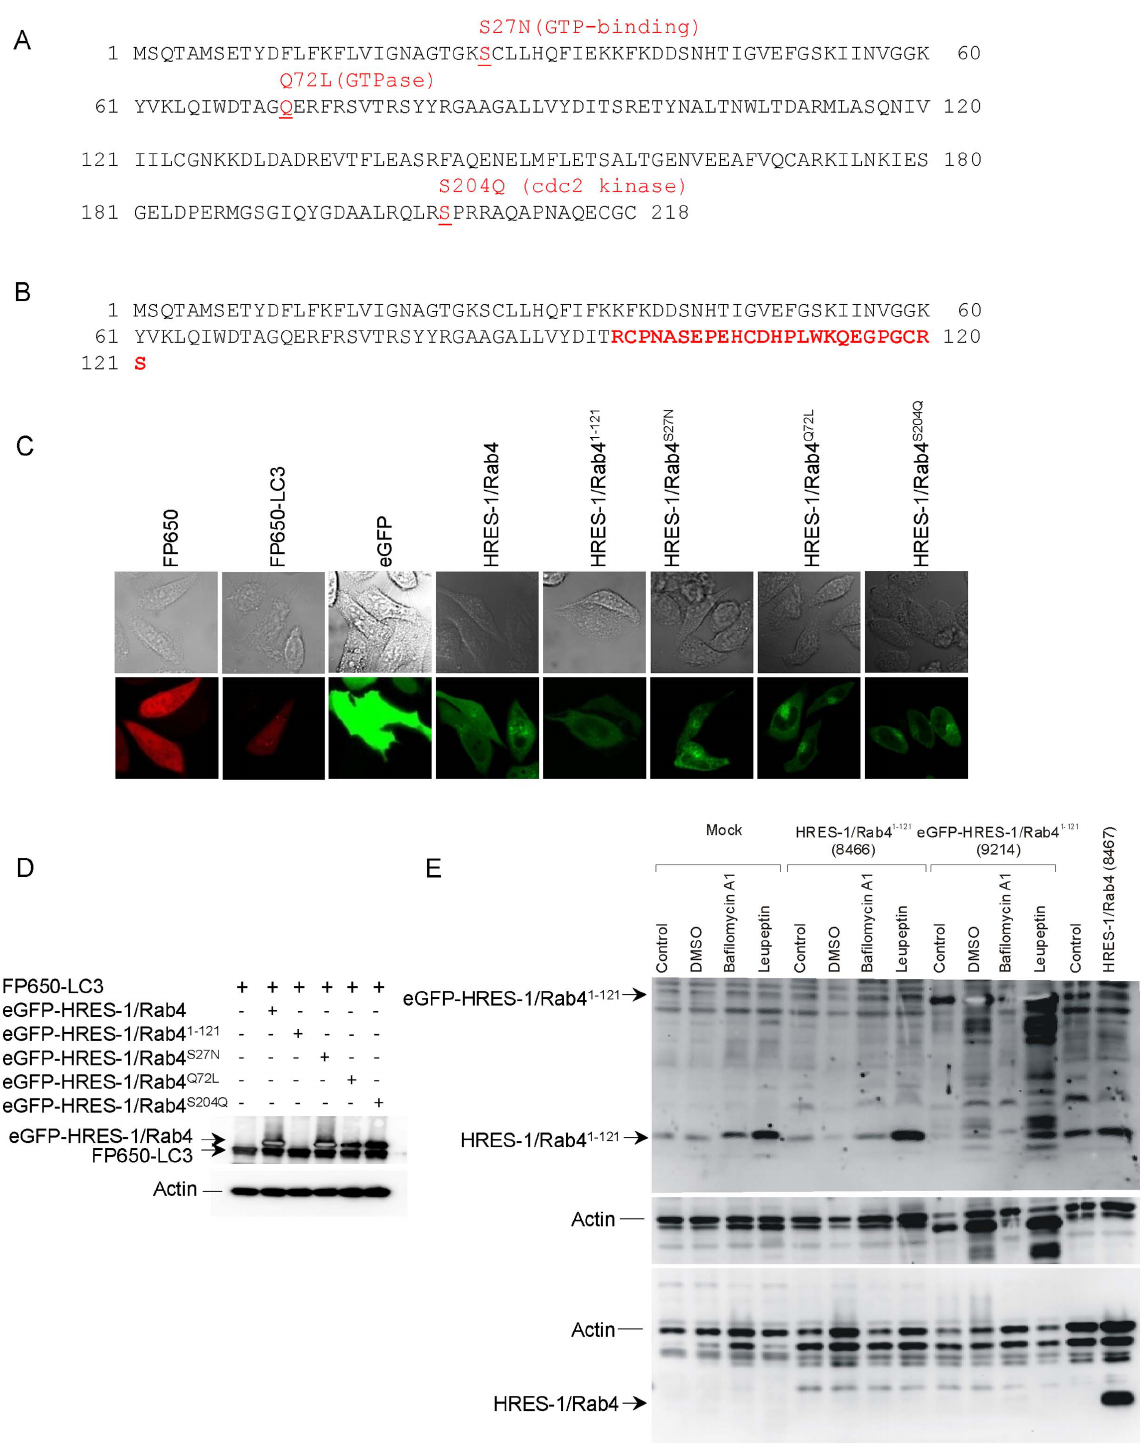
Figure 1. Detection of LC3 fused to FP650 (FP650-LC3) and HRES-1/Rab4 isoforms, including wild-type HRES-1/Rab4, C-terminally truncated HRES-1/Rab4 1–121 , dominant-negative/GTP binding-deficient HRES-1/Rab4 S27N , constitutively active/GTPase-deficient HRES-1/Rab4 Q72L and phosphorylation-resistant form HRES-1/Rab4 S204Q , tagged with eGFP. A, Functional domains of proteins encoded by the HRES-1/Rab4 cDNA at 1q42 [12] (Genbank accession number: AY585832). Amino acid changes previously shown to affect Rab4 activity are typed in red. HRES-1/Rab4 S27N prevents GTP binding and acts as a dominant negative mutation [20]. HRES-1/Rab4 Q72L is constitutively active due to elimination of GTPase activity [21]. HRES-1/Rab4 S204Q will not be phosphorylated by p34cdc2 kinase in mitotic cells and remains endosome- associated throughout the cell cycle [22]. B, Amino acid sequence of HRES-1/Rab4 1–121 , representing a 36-nucleotide out-of-frame deletion, is attributed to alternative splicing (GenBank submission number 1591873). This results in a frameshift with an amino acid sequence corresponding to the 96 N-terminal residues of HRES-1/Rab4 continuing into 25 C-terminal residues (typed in red characters), which are unrelated to the amino acid